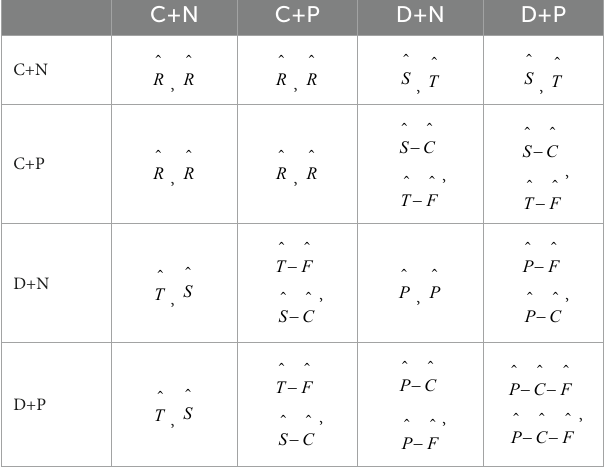
TABLE 4 Payoff matrix in the prisoner’s dilemma game. over neighbors of every subject, the original network can be reduced to a two-node graph with self-loops, as shown in Figure 3B. In the original graph, a peripheral node connects to two other peripheral nodes and two central nodes, and a central node connects to six peripheral nodes and two other central nodes. Thus, the link weight of the self-loop of the peripheral node is 0.5, the same as the link weight from the central node to the peripheral node. The weight of the self-loop of the central node is 2 2 6 0 25/ . + ( ) = , and and the TABLE 5 Payoff matrix in the two-stage prisoner’s dilemma game. link weight from the peripheral node to the central node is 6/ (2+6)=0.75. C+N C+P